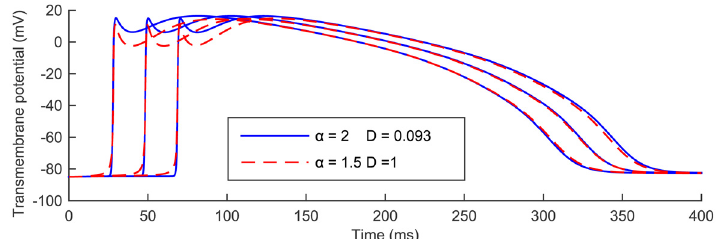
Fig 9. Temporal evolution for t 2 [0,400 ms] of the standard solution with reduced conductivity and the fractional solution with unit conductivity parameter at three equally spaced nodes P 1 , P 2 , P 3 , in the spatial domain [0, 1 cm]. The continuous blue line corresponds to the standard solution obtained with α = 2, D = 0.093 mS (cid:3) cm − 1 . The dashed red line represents the fractional solution obtained by setting α = 1.5, D = 1 mS (cid:3) cm − 1 . In both cases the stimulus I stim = 40 μ A (cid:3) cm − 3 was applied on [0,0.05 cm] at t stim = 10 ms for two consecutive milliseconds and then